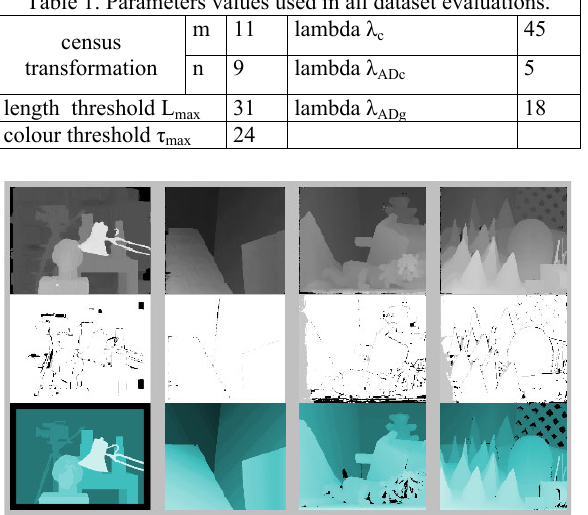
Figure 8. Top : final resulting disparity maps after full match- ing procedure using the four stereo pairs of Middlebury evalu- ation platform. Middle : “bad” pixels of the produced disparity maps evaluated for the 0.75 pixel error threshold. Mismatched pixels in occluded areas are indicated by gray colour, non-oc- cluded areas in black. Bottom : True disparity maps.